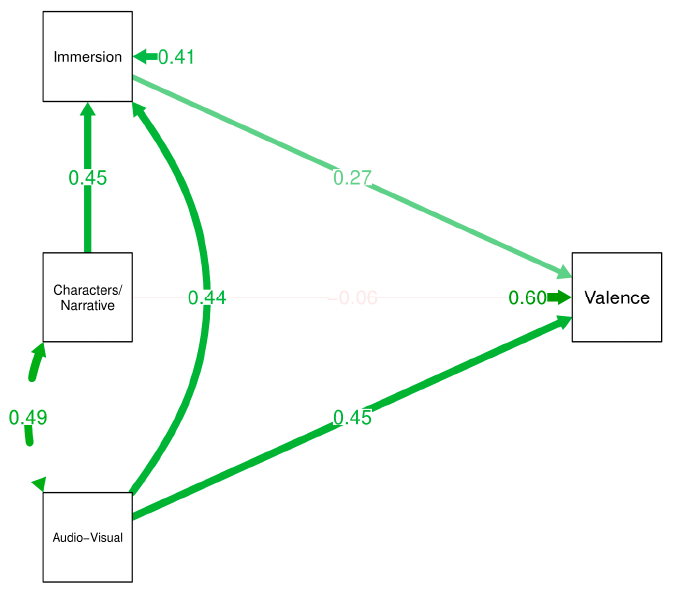
Figure 2. Path diagram for partial mediation model of affective valence. Note: aud = audio-visual; chr = characters and narrative; imm = immersion; vln = affective valence. Table 3. Structural Equation Modelling Results.